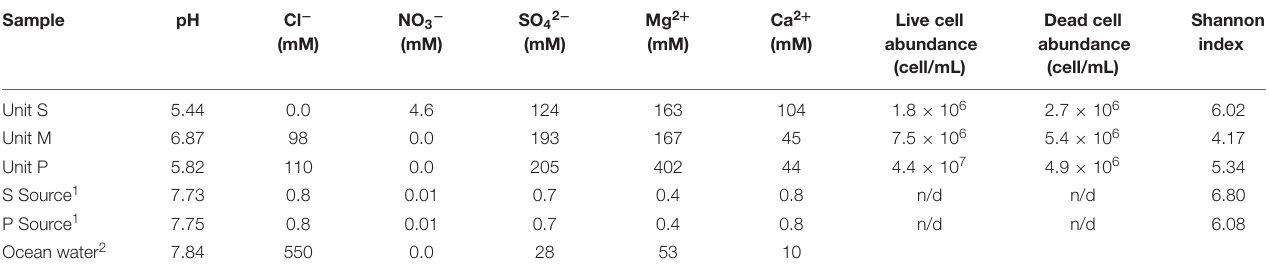
TABLE 1 | Aqueous chemistry, microbial cell abundances, and non-parametric microbial community diversity indicators of wFGD slurry and source water. All measurements were made on samples collected in August, 2016, except for cations, which were measured in samples collected in August 2015. n/d = not determined. Ocean water chemistry is included for comparison to the wFGDs.